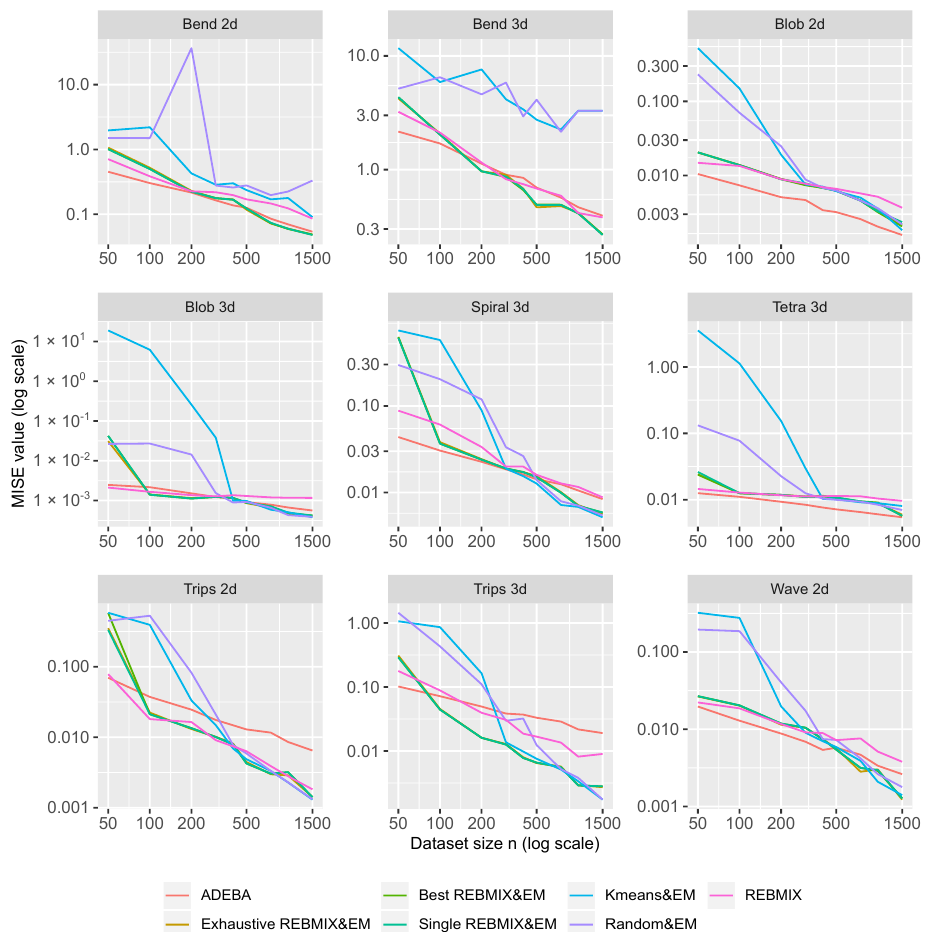
Figure 7. Density-estimation performance evaluation of Exhaustive REBMIX&EM strategy, Best REBMIX&EM strategy, Single REBMIX&EM strategy, Kmeans&EM, Random&EM, and ADEBA on datasets sampled from multivariate distributions in